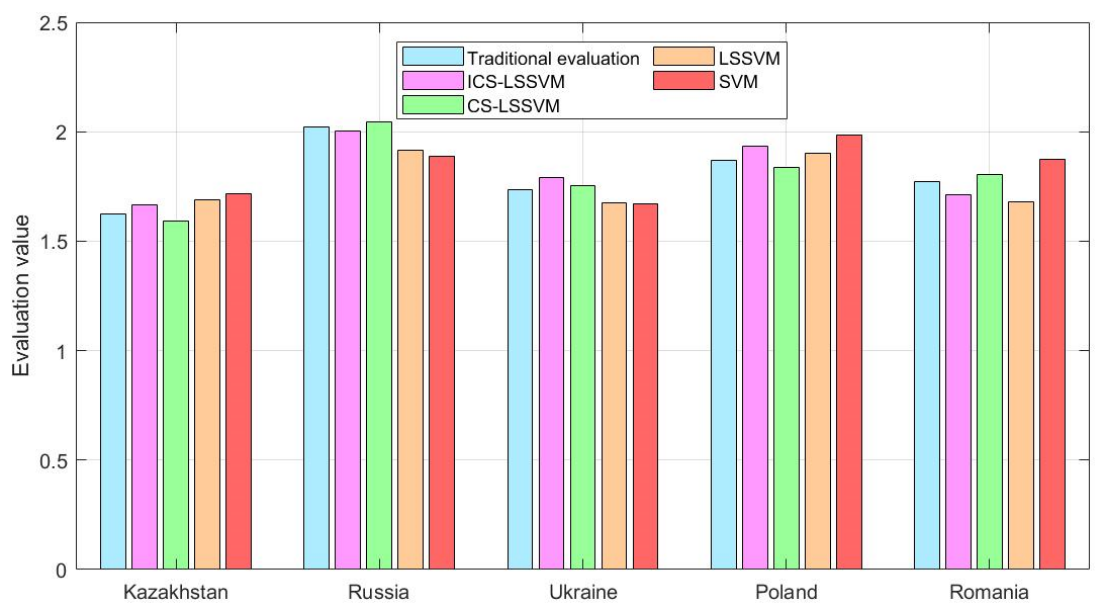
Figure 3. Comparison of estimation results. As displayed in Figure 3 and Table 4, the evaluation result derived from ICS-LSSVM is the closest to the traditional assessment value. The accuracy and stability of the intelligent estimation approach have been proved in this study. In contrast with SVM, the estimation values of LSSVM are closer to the conventional ones. The cause lies in the fact that LSSVM employs kernel function to transform prediction problems into equations. The precision and classification capability of LSSVM is superior, especially in coping with unstable data. Figure 4 illustrates the relative errors of the four techniques. It can be found that ICS-LSSVM has the strongest fitting and learning ability. The number of relative errors ranging in [ − 3%, 3%] of ICS-LSSVM, CS-LSSVM, LSSVM and SVM is equivalent to 5, 2, 1 and 0, respectively. There exist two countries in ICS-LSSVM and only one country in CS-LSSVM with a relative error within [ − 1%, 1%]. In line with the absolute value, the maximum of relative errors is − 2.05%, 3.67, − 5.26% and − 6.59% for ICS-LSSVM, CS-LSSVM, LSSVM and SVM, respectively, while the corresponding minimum of relative errors is 0.87%, − 0.97%, 1.86% and − 3.68%. The study demonstrates that the proposed approach has the strongest nonlinear fitting ability together with the most satisfactory accuracy and